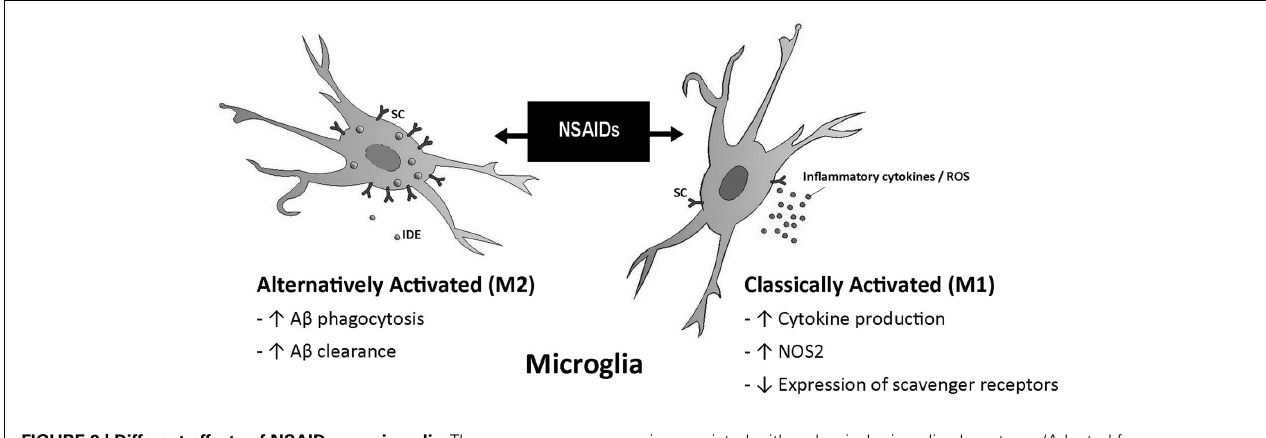
FIGURE 2 | Different effects of NSAIDs on microglia. The response to NSAIDs may differ depending on whether they are used in early stages of disease, in which microglia present an alternatively activated phenotype compared with late stages which